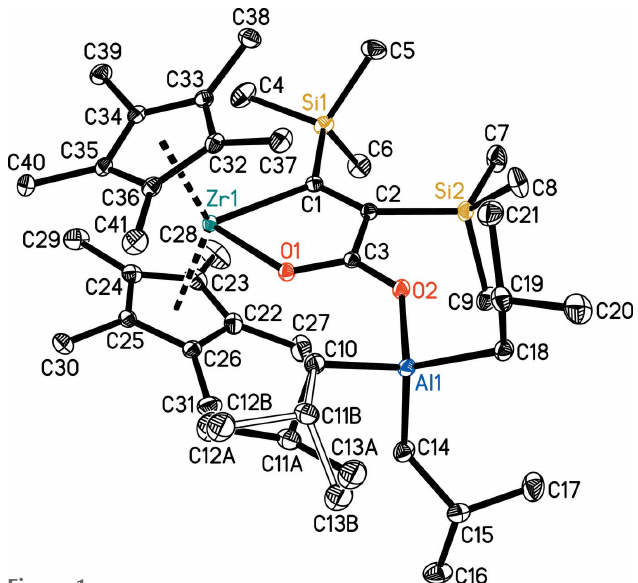
Figure 3 Packing diagram for 2 viewed along the a axis. Displacement ellipsoids correspond to the 30% probability level. H atoms and lower occupancy sites have been omitted for